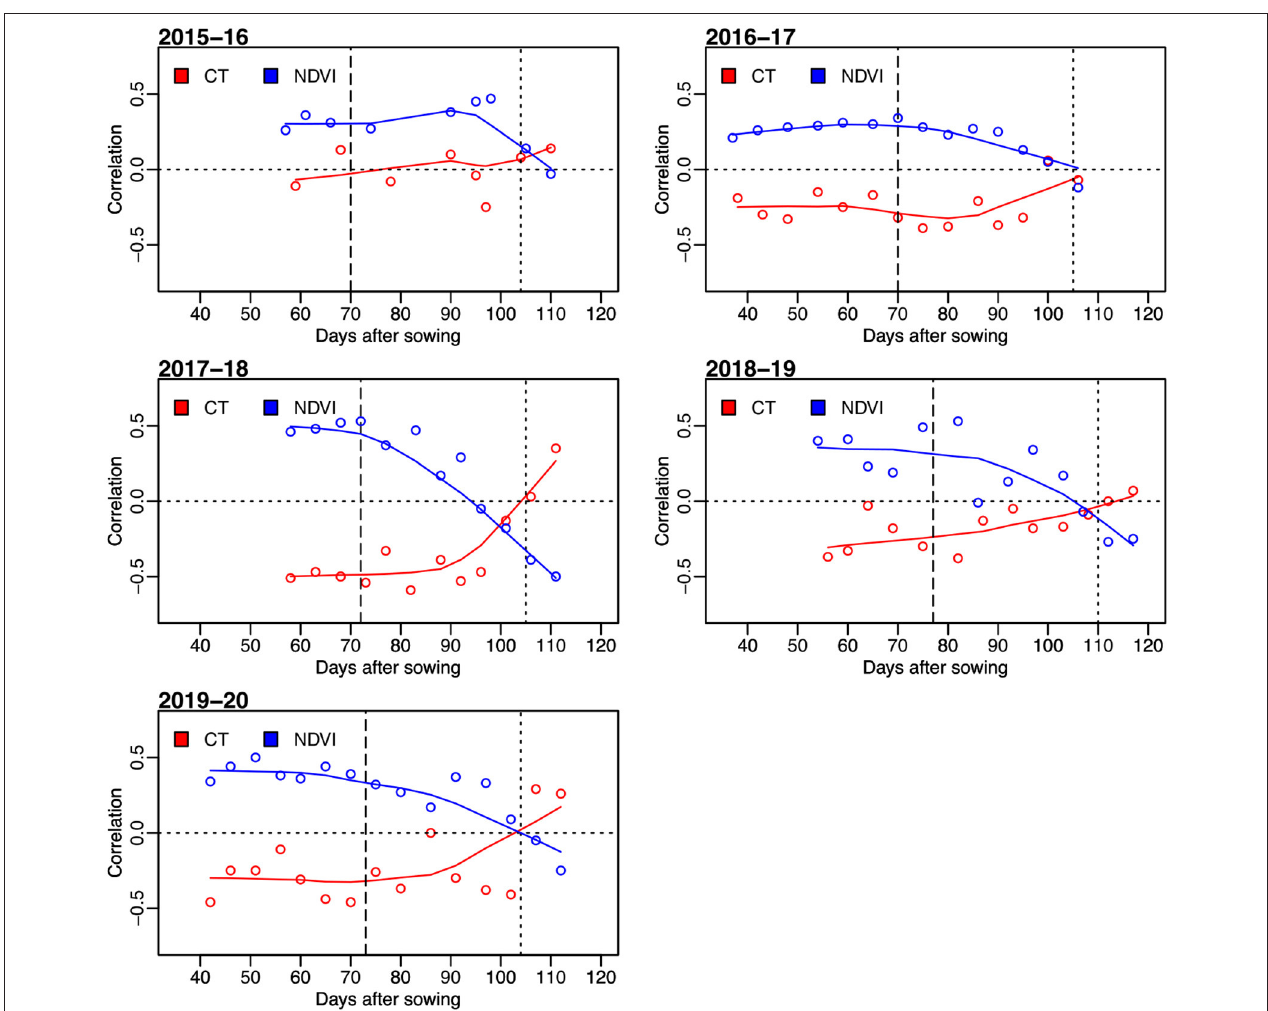
FIGURE 2 | Correlation between grain yield and sensor-based secondary traits of NDVI and CT for observations on days after sowing in five wheat growing seasons from 2015–16 to 2019–20. The horizontal dotted lines represent the correlation value of 0. The vertical dashed lines indicate average days to heading, and the vertical dotted lines represent the average days to physiological